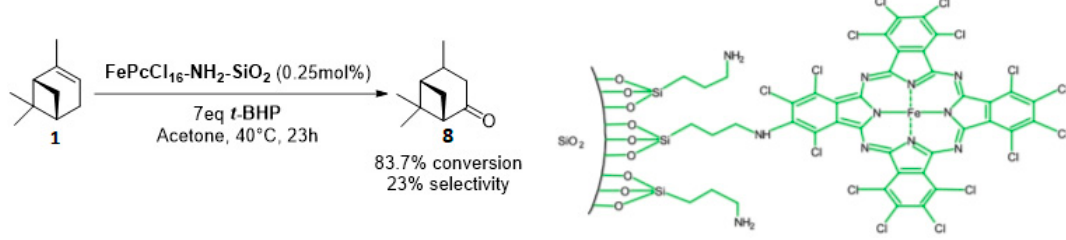
Figure 11. FePcCl 16 -NH 2 -SiO 2 -catalyzed oxidation of α -pinene (adapted from reference [67]).